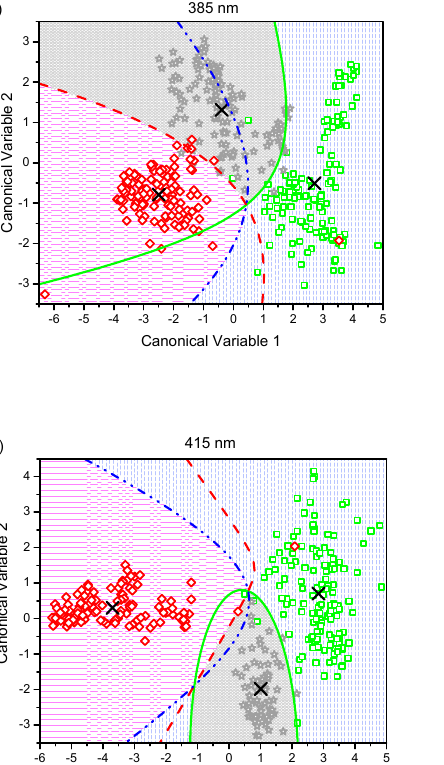
Table 3. Classification error rate of the quadratic discriminant model applied using the classification and cross-validation strategies.